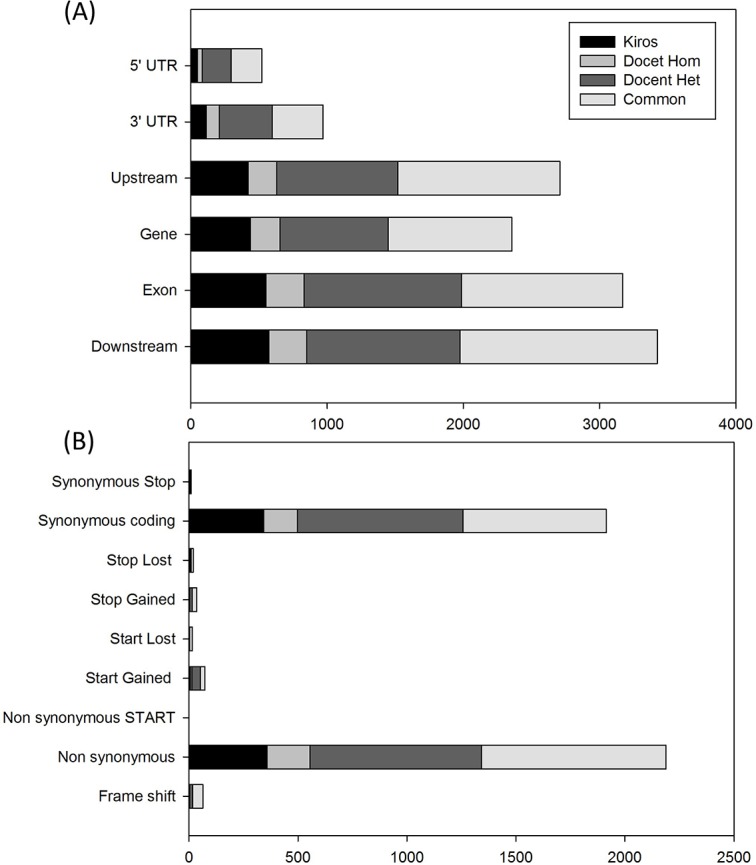
SNP classification according to their positions (A) and their effect (B).